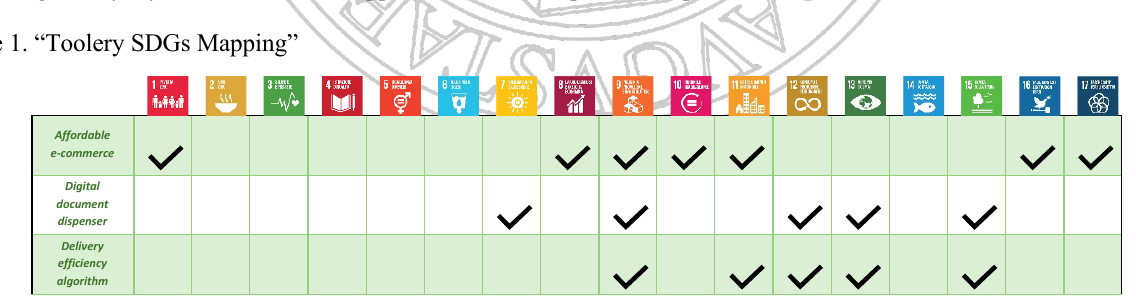
Table 1. “Toolery SDGs